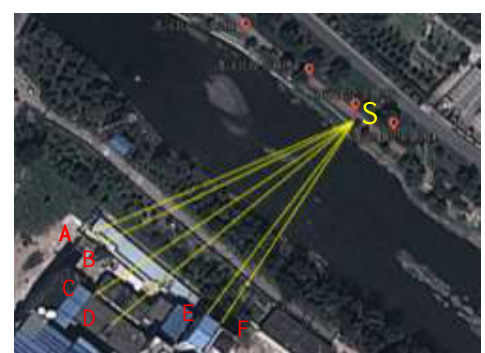
Figure 11. Targets distribution of the stereo measurement test By compare the results of the distances and coordinates measured by GE and the method in 3DGIS we find that the stereo integrated 3DGIS enable users to browse the overall image as well as the detail stereo image in the real world. But Figure 10. Placemarks display and edit in stereo integrated the camera calibration error and the shifting between the MTI 3DGIS position and the cameras both decrease the measurement accuracy of the stereo integrated 3DGIS. Also the drift of the MTI data and GPS position data lead a poor quality data of the camera station location that have been used in the calculation. Table 1. Comparison between the distances measured by GE and our method ( 𝑑 𝑟 : distance measured by GE, 𝑑 𝑠 :distance measured by our method) Routes